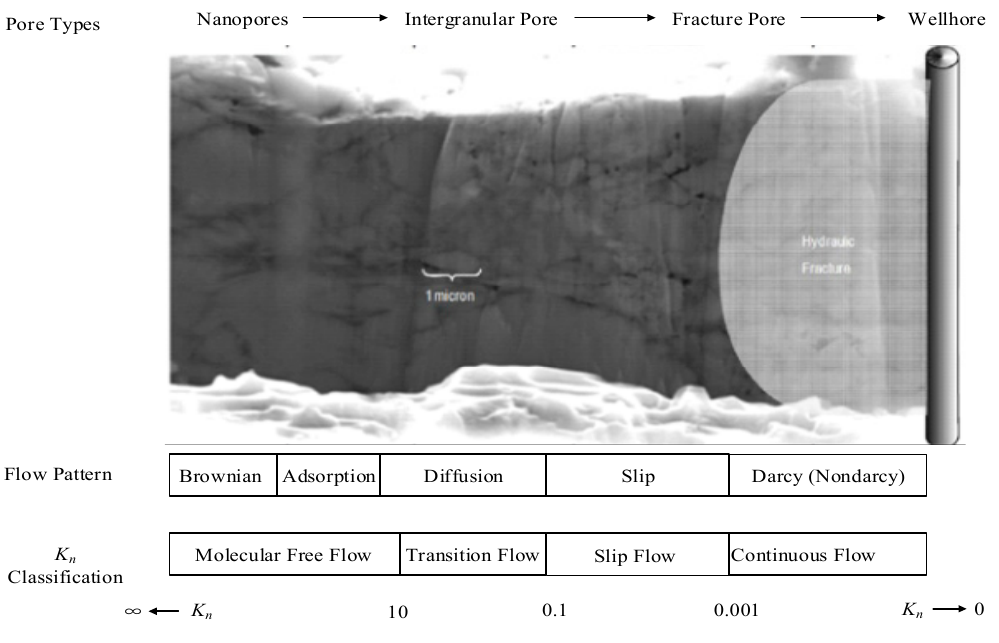
Figure 1. Gas flow regimes in shale reservoirs according to Knudsen number.